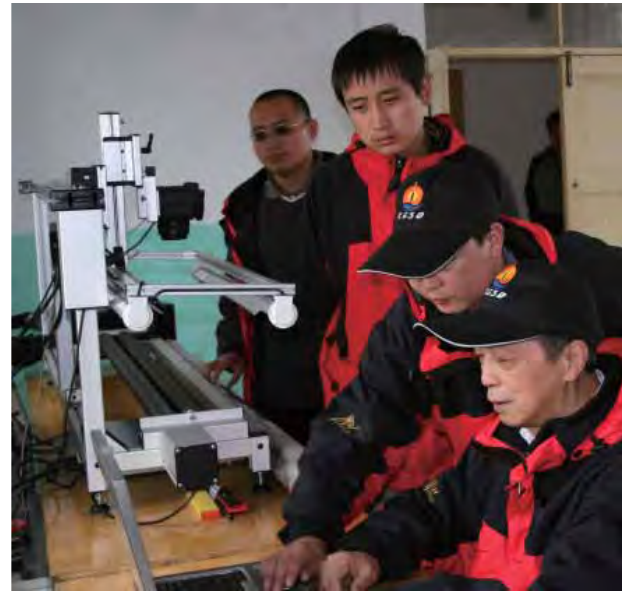
Figure 3. ICDP´s optical core scanning system in use at the shore base.